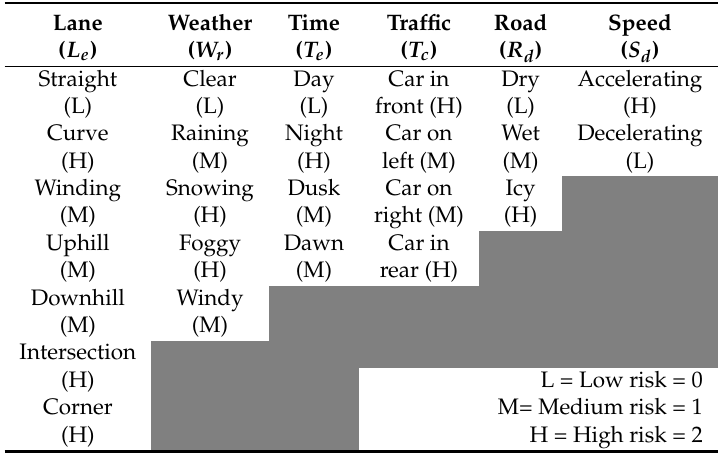
Table 1. Vehicle context parameters and risk values [12].